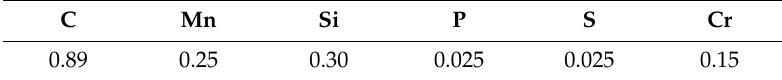
Table 1. Chemical composition of steel used (wt